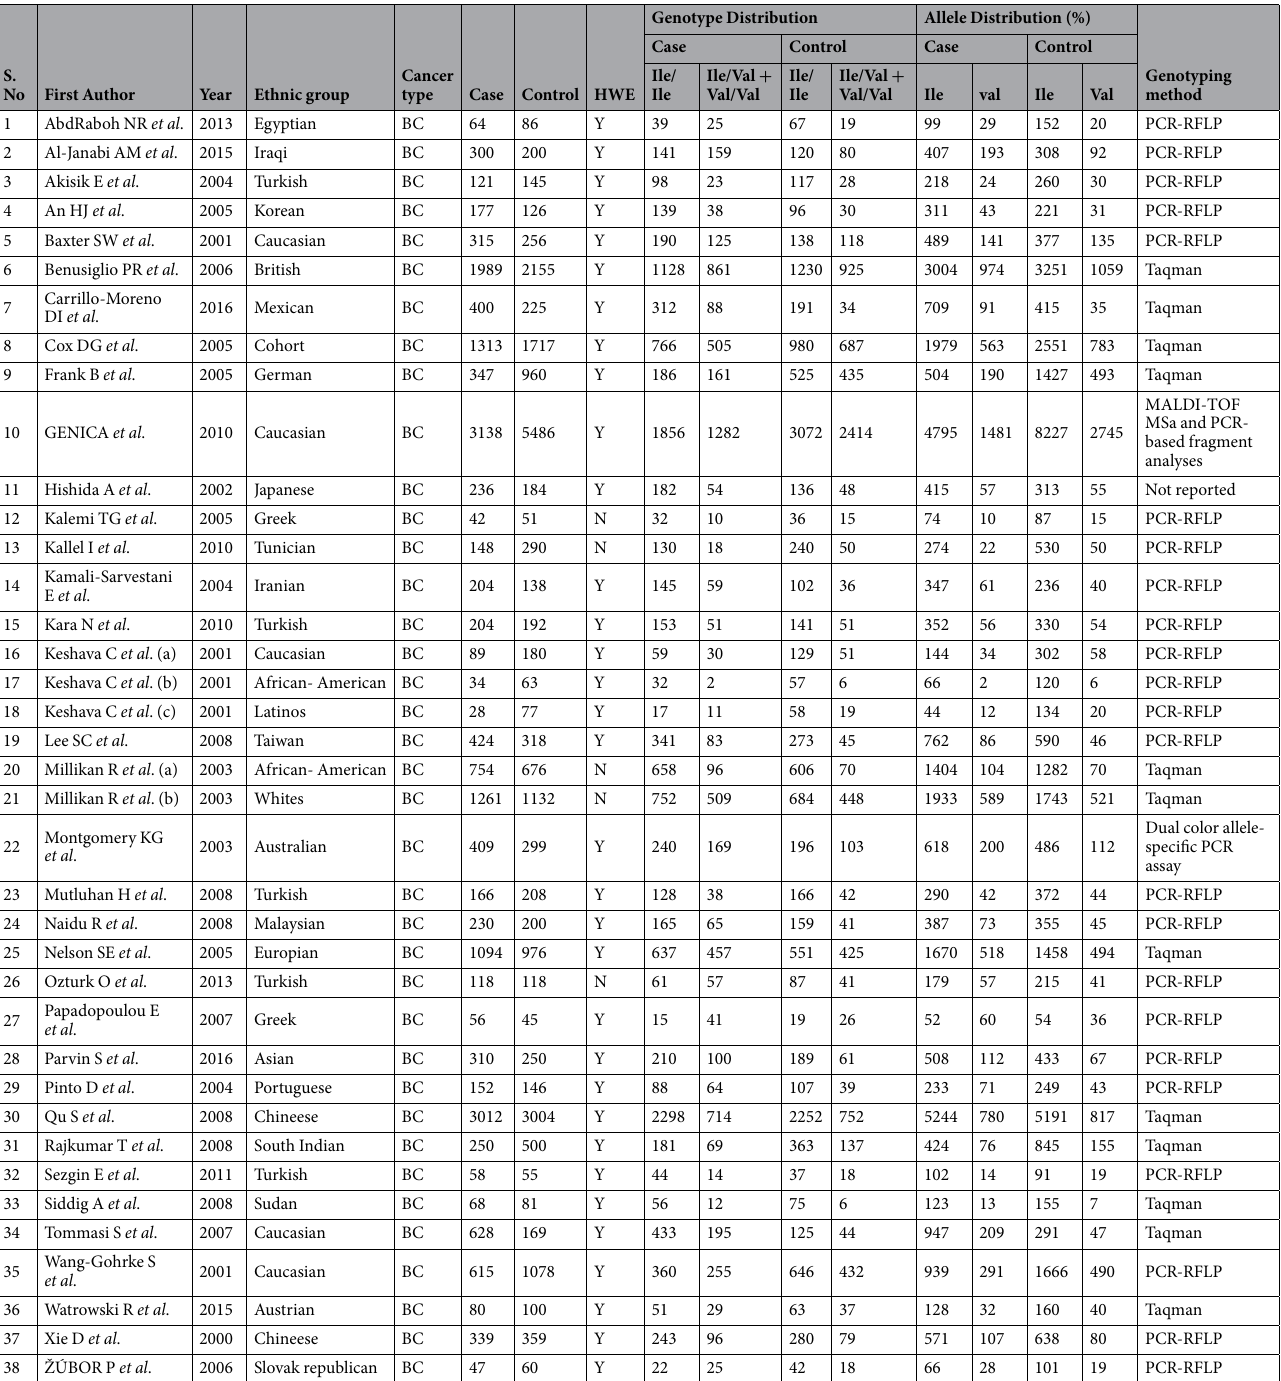
Table 1. Characteristics and distribution of Her2 polymorphism in each study involved in meta-analysis. Keshava et al . Caucasian ethnic group designated as (a), African-American ethnic group designated as (b) and Latinos ethnic group designated as (c). Millikan et al . African-American ethnic group designated as (a) and whites designated as